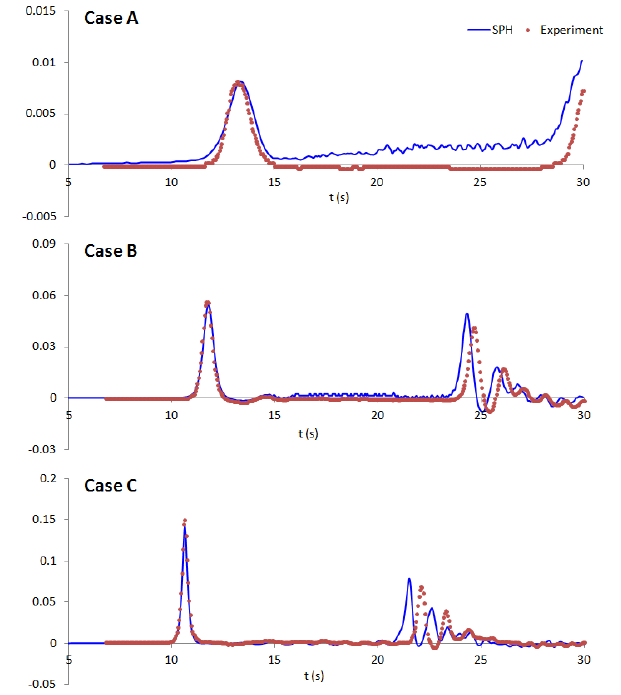
Fig. 3. Water levels recorded at gage 4.